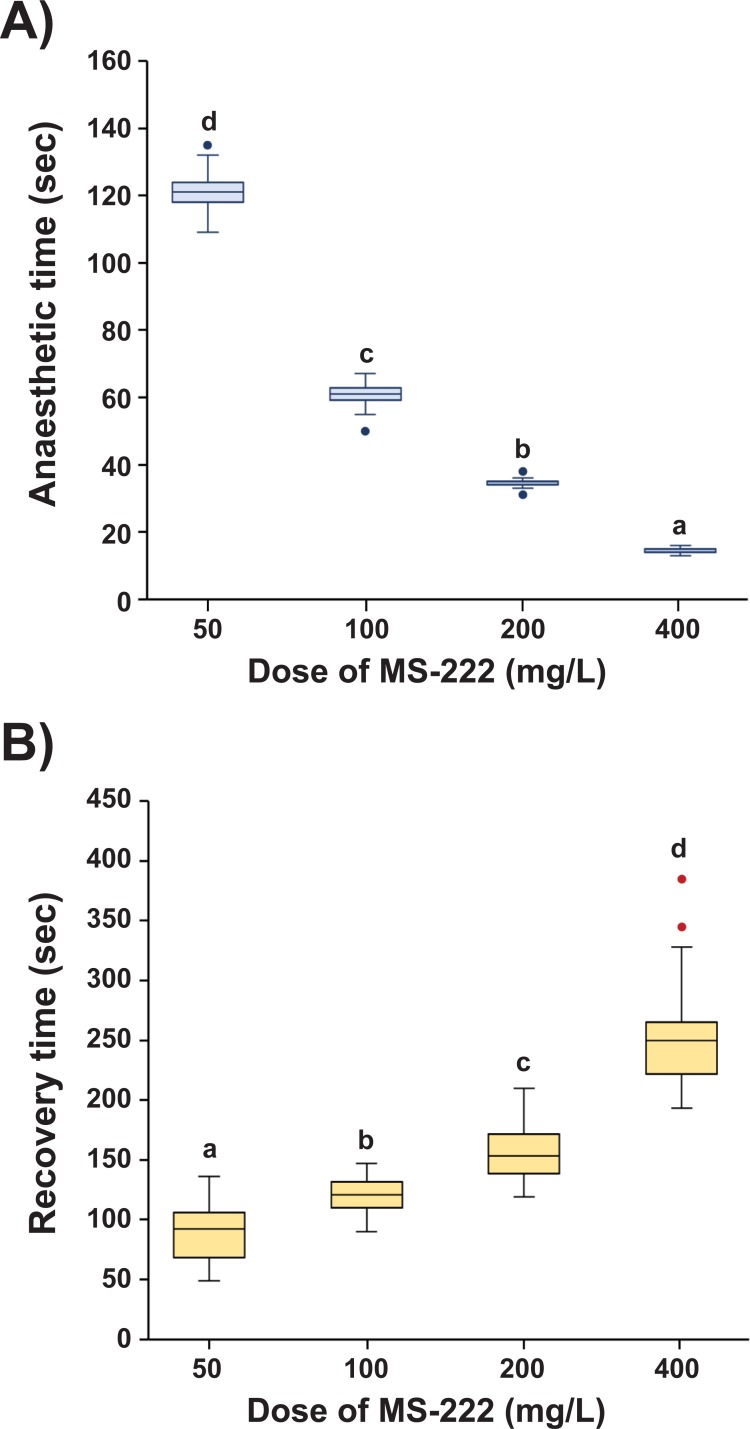
Validation of anesthetic (A) and recovery (B) times with different doses of MS-222 on an individual-basis examination. In the box plot, the lower and upper boundaries of each box indicate the 25th and 75th percentiles, respectively (N = 36). A line within the box marks the median value. Whiskers above and below the box indicate the 90th and 10th percentiles, respectively. Outliers are indicated by dots above and/or below the box. Mean ± SD with different letters (a-c) at each dose level indicate the statistical difference at P < 0.05 based ANOVA followed by Tukey’s post hoc analysis.